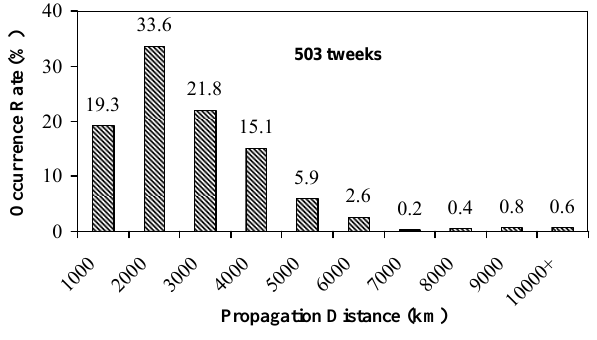
Fig. 6. Percentage occurrence rate of tweeks as a function of prop- agation distance determined from the observations made in the Fig.6. Percentage occurrence rate of tweeks as a function of propagation distance determined from the observations made in the period from September 2003 – July 2004.